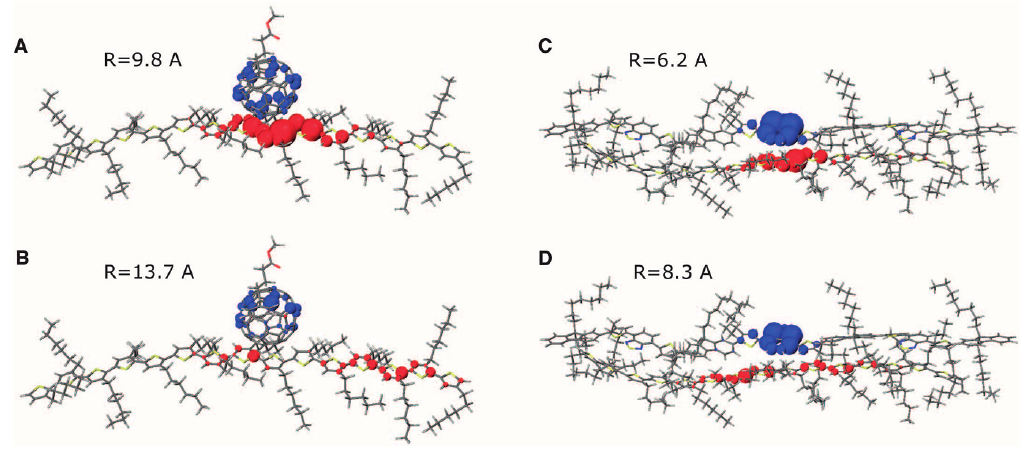
Figure 2. Micro-electrostatic simulations of the charge distribution at the BM ( A , B ) and P3HT/F8TBT poly(9,9-dioctyl fl uorene poly-3(hexylthiophene) (P3HT)/PC 60 - co -benzothiadiazole) ( C , D ) heterojunction, with electron and hole densities shown in blue and red, respectively. ( A , C ) Charge distribution in the lowest CT-state configuration and ( B , D ) in the excited CT state configuration created upon absorption of an IR-push photon. R, average electron-hole separation. Cited from [56]. Copyright 2012,